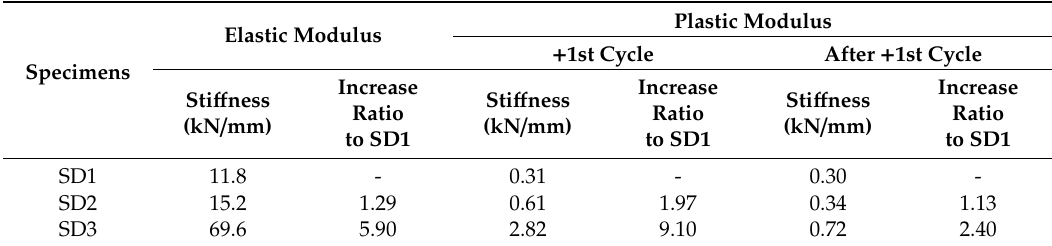
Table 3. Elastic and plastic modulus of tested